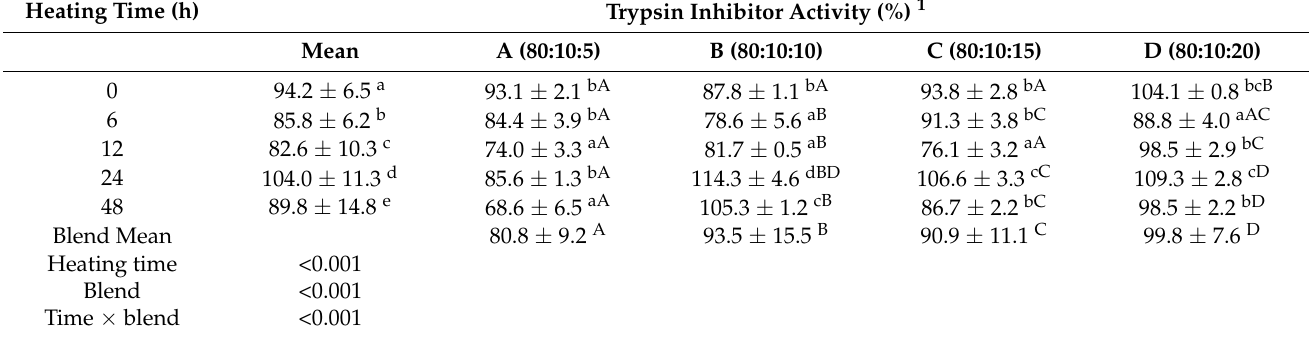
Figure 2. ( A ) Measurement of the trypsin inhibitory effect of pure potato protein (absorbance measurement at 450 nm over the quantity of potato protein in the assay), ( B ) positive control without potato protein, and ( C ) trypsin inhibitory activity of all fibers (MD DE 2:MD DE 21:PP — A (80:10:5), B (80:10:10), C (80:10:15), and D (80:10:20)) vs. heating time (different letters indicate significant differences between heating times (lower case) or blends (upper case) ( p < 0.05)). Table 2. Means and standard deviations of the ratio of IA (mg trypsin inhibited per g protein) of the potato protein incorporated in the spun and heated protein – maltodextrin fibers, and the IA of potato protein isolate powder.